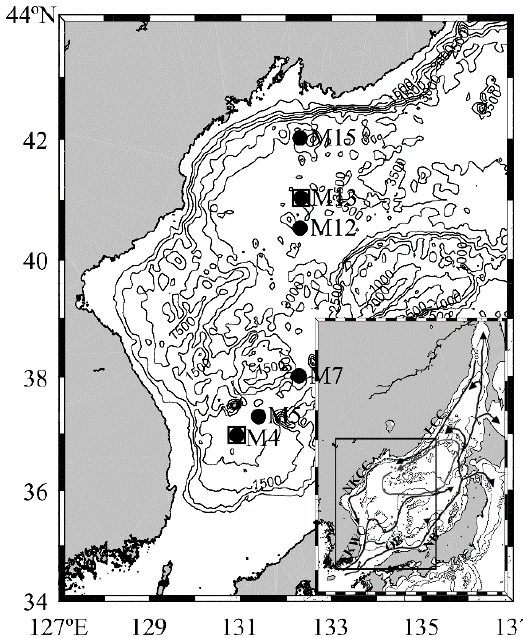
Figure 1. A sampling station map in the East Sea. CTD, fluorescence, particulate organic matter, and zooplankton data were obtained at six stations (●) , and stable carbon and nitrogen isotope ratios of zooplankton were obtained at two stations ( □ ). Inset shows the general location of the study area, and isobaths are shown at 500 m intervals. The major currents in the East Sea are from Park et al. (2013). EKWC, East Korea Warm Current; LCC, Liman Cold Current; NB, Near-Shore Branch of Tsushima Warm Current; NKCC, North Korea Cold Current; OB, Off-Shore Branch of Tsushima Warm Current.